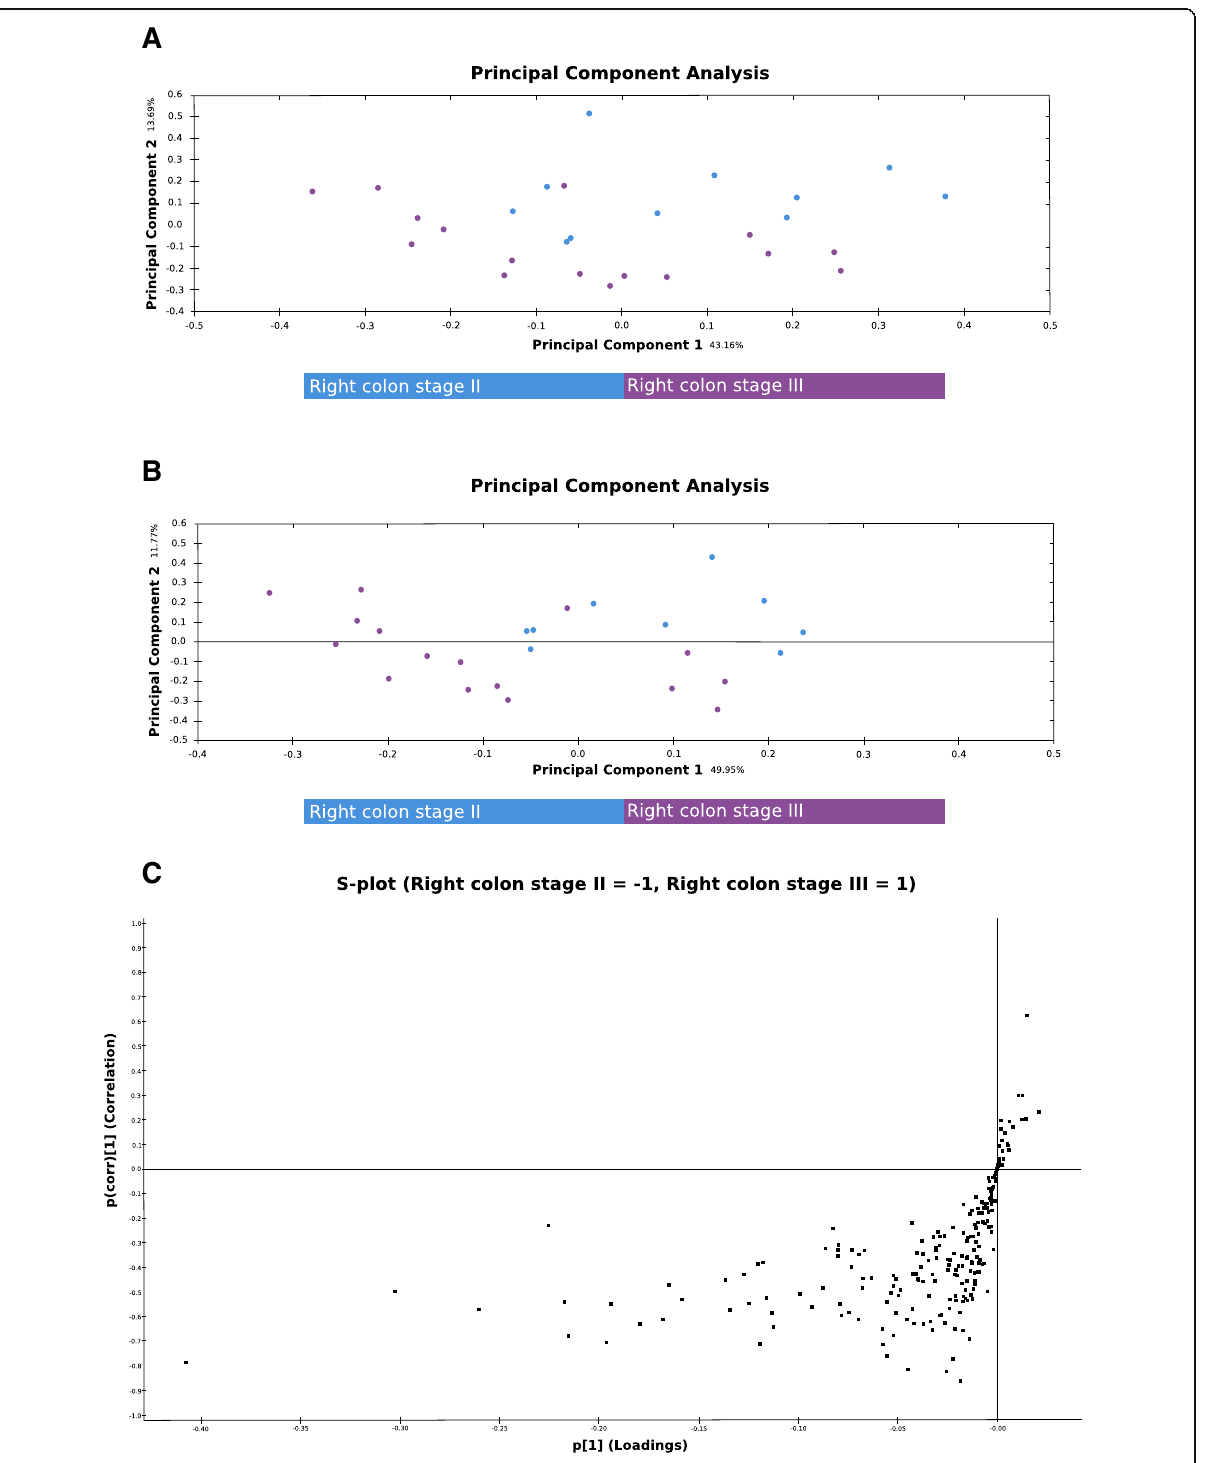
Fig. 1 Separation between proteins expressed in samples from patients with right-sided stage II and III CRC. a shows the PCA biplot when all proteins were considered b shows the PCA biplot when only proteins that passed the cutoff of a Mann-Whitney U test p-value of less than 0.05 were considered. Blue dots represent samples from patients with stage II cancer in the right colon and purple dots represent samples from patients with stage III cancer in the right colon. c shows the S-plot generated by OPLS-DA modeling. The upper right quadrant of the S-plot, with positive values, shows proteins with higher levels in samples from patients with right-sided stage III CRC. The lower left quadrant, with negative values, shows proteins with higher levels in samples from patients with right-sided stage II